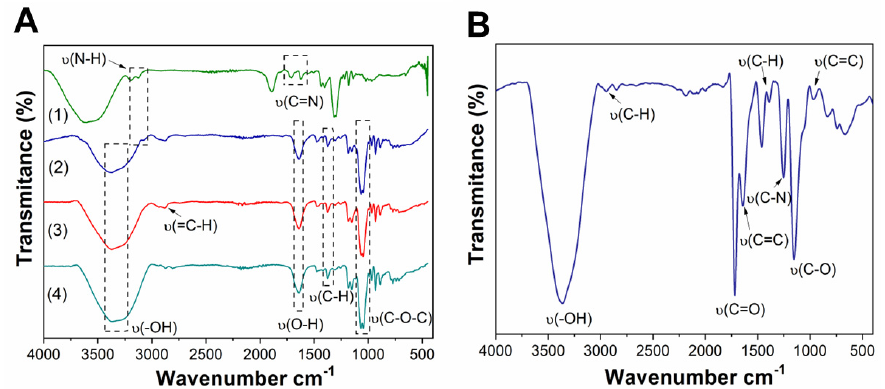
Figure 2. ( A ) Fourier Transformed Infrared (FTIR) spectra of the agarose-activated supports: (1) GLUT-agarose; (2) MANAE-agarose; (3) Glyoxyl-agarose, and (4) Agarose beads. ( B ) FTIR of the amino C2 methacrylate beads (Purolite) support.